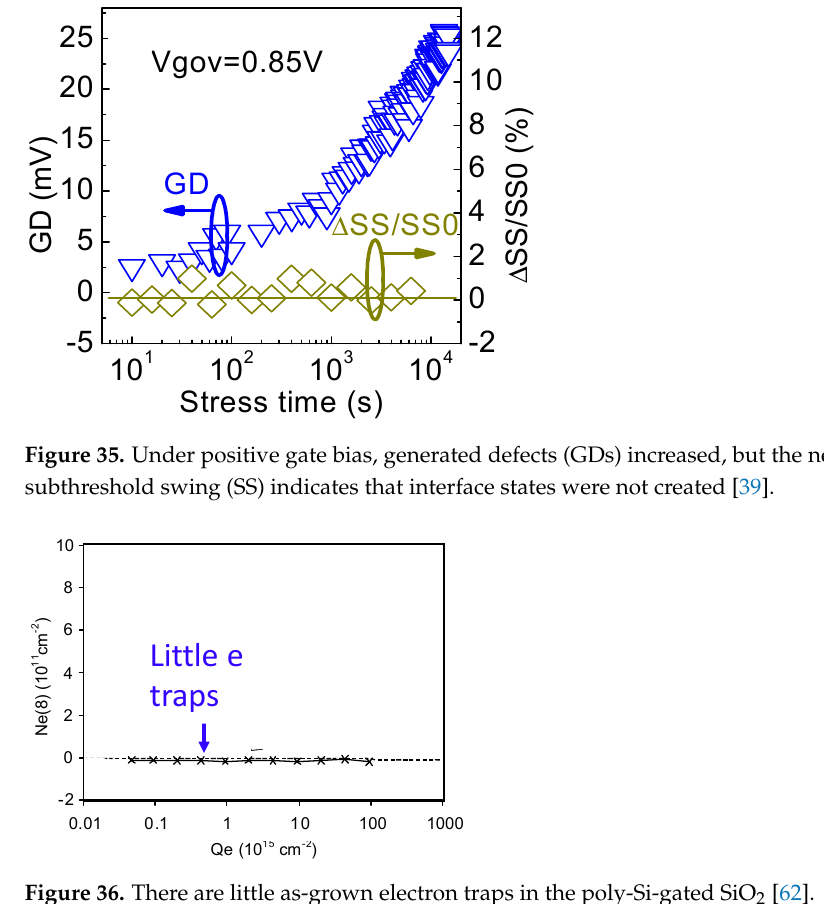
Figure 36. There are little as-grown electron traps in the poly-Si-gated SiO 2 [62].